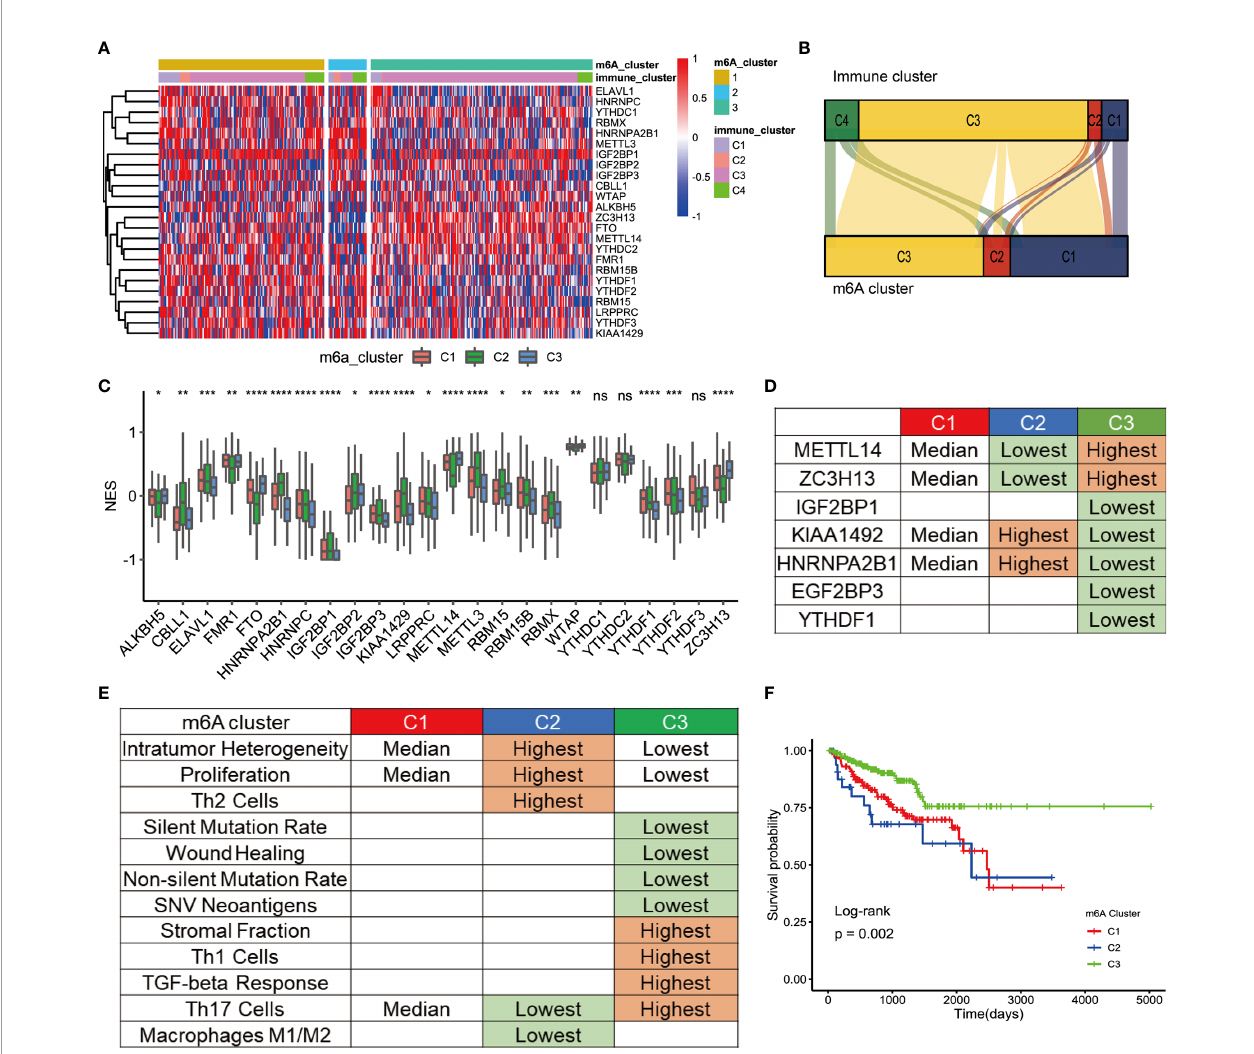
FIGURE 2 | TME cell in fi ltration characteristic of m6A regulation patterns. (A) The cluster was used to identify three expression patterns of 24 m6A regulators in 498 prostate cancers. Standardize the expression of each gene. (B) Alluvial diagram showing the changes of m6A regulators clusters and immune clusters of the prostate cancer samples. (C) The expression of 24 m6A regulators in three clusters. cluster1, red. cluster2, green, cluster3, blue. The upper and lower ends of the boxes represented interquartile range of values. The lines in the boxes represented median value, and black dots showed outliers. The asterisks represented the statistical p value (*P<005; **P<001; ***P<0001; ****P<0.0001); ns, Not Statistically signi fi cant. (D) Expression characteristics of 7 key m6a regulators in 3 types of samples. “ Highest ” means that the mRNA expression of gene is the highest among the three group (p<0.05). “ Lowest ” means that the mRNA expression of gene is the Lowest among the three group (p<0.05). “ Median ” means: Compared with the other 2 groups, median is higher than one group (p<0.05) and lower than the other group (p<0.05). (E) Key characteristics of three m6a expression clusters. “ Highest ” means that the mRNA expression of gene is the highest among the three group (p<0.05). “ Lowest ” means that the mRNA expression of gene is the Lowest among the three group (p<0.05). “ Median ” means: Compared with the other 2 groups, median is higher than one group (p<0.05) and lower than the other group (p<0.05). (F) Survival analyses for the three m6A expression patterns based on 405 patients with prostate cancer from TCGA database including 157 cases in m6A regulators cluster-1, 36 cases in m6A regulators cluster-2, 212 cases in m6A regulators cluster-3. Kaplan-Meier curves with Log-rank p value 0.002 showed a signi fi cant survival difference among three m6A expression patterns. The m6Acluster-3 showed signi fi cantly better FPI than the other two